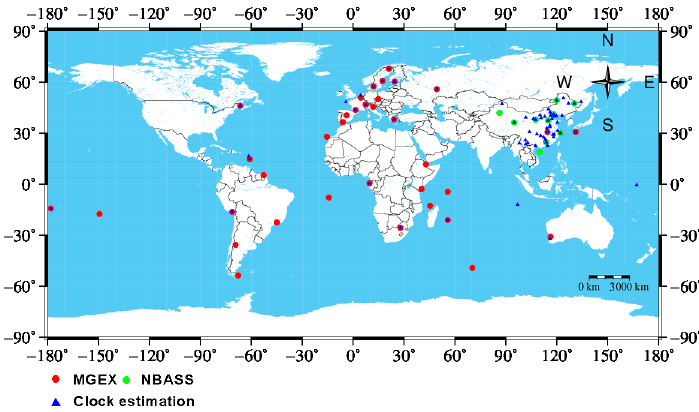
Figure 2. Distribution of stations which are used in the estimations of real-time orbits and clocks, the circles denote the stations for orbits estimation while the blue triangles denote stations for clock estimation.